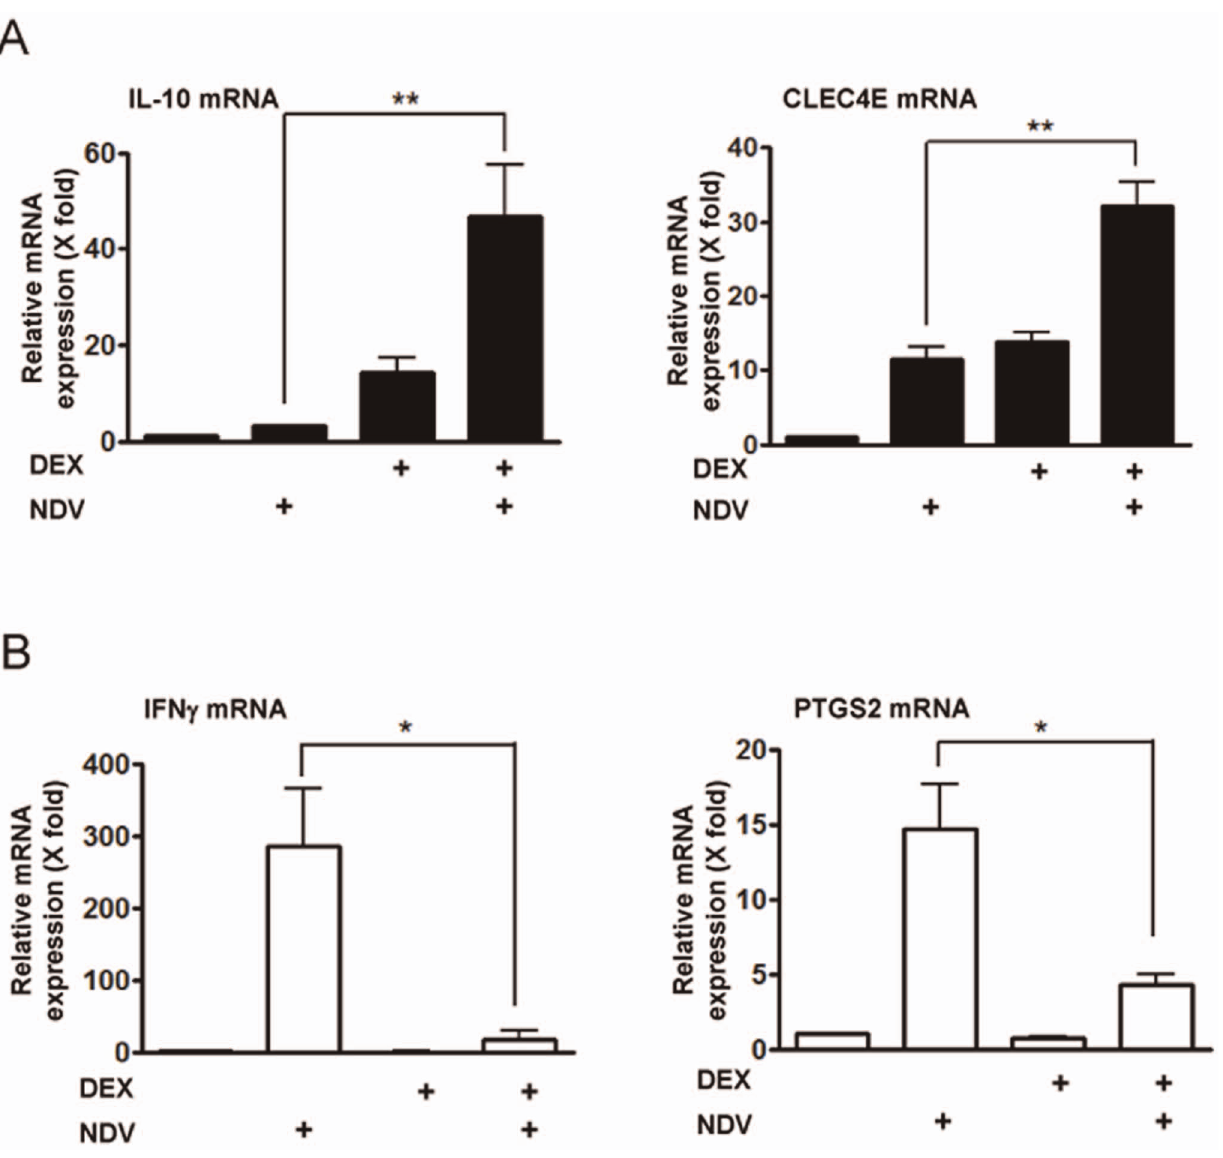
Figure 1. DEX pre-treatment and NDV infection cooperatively regulated mRNA expression of the four genes in DCs. Bone marrow- derived DCs were pre-treated with DEX (10 2 6 M) for 30 min, and were infected with NDV (MOI=10) for 6 hours. mRNA levels of top four genes in Table S2 were measured in the real-time qPCR by using newly designed primers (panel A : IL-10 and CLEC4E : genes whose mRNA expression was cooperatively enhanced by DEX pre-treatment and NDV infection, panel B : PTGS2 and IFN c : genes whose mRNA expression was stimulated by NDV infection but repressed by DEX pre-treatment). Their C t values were normalized with those of GAPDH , and relative mRNA expression (fold changes) was calculated by comparing to the control obtained in the absence of DEX pre-treatment and NDV infection. Bars represent means and standard errors of fold changes of their mRNA expression obtained in three independent experiments. *: p , 0.05, **: p , 0.01, compared the 2 conditions